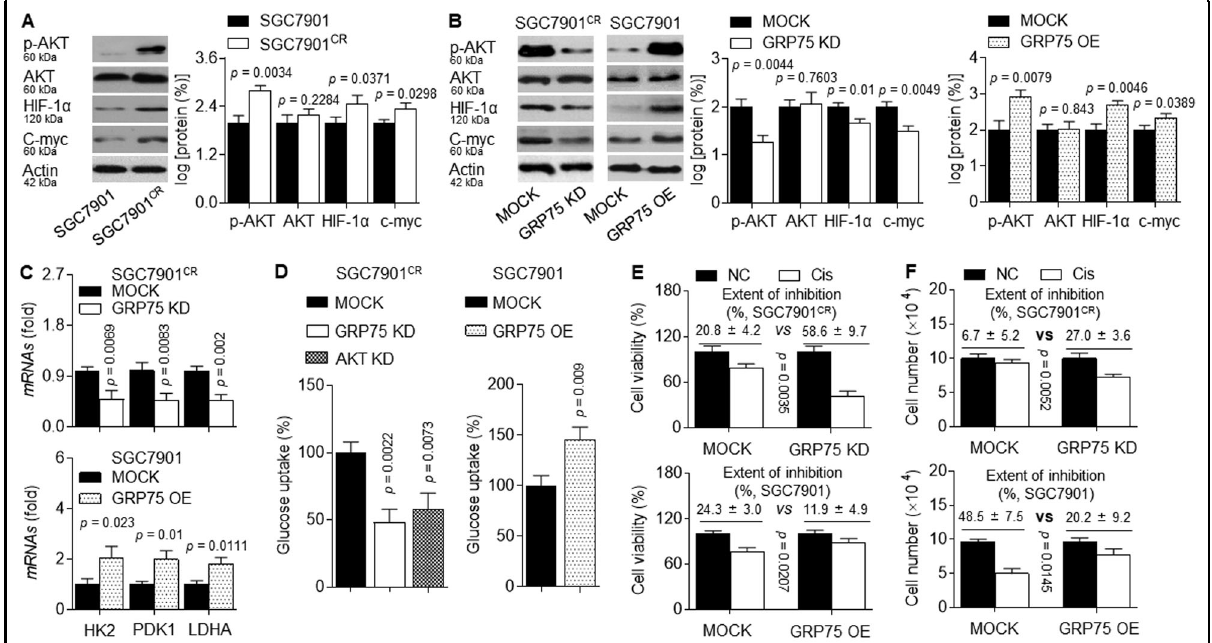
Fig. 4 Effects of GRP75 on metabolic reprogramming. A Western blot (left) and quantitative analysis (right) of the levels of p-AKT, HIF-1 α , and c- myc proteins in GC cells. B – F SGC7901 CR cells were transfected by scrambled or GRP75 siRNA, while SGC7901 cells were transfected by scrambled or GRP75 plasmids. After then, they were treated with 5 or 2.5 μ M of cisplatin for 24 h. B Western blot (left) and quantitative analysis (right) of p-AKT, HIF- 1 α , and c-myc proteins. C qPCR analysis in triplicate of HK2, PDK1, and LDHA mRNAs. D Glucose uptake ability was evaluated and quantitatively calculated in triplicate. E and F The cell viabilities and cell numbers were determined, and the extent of inhibition was calculated in triplicate.